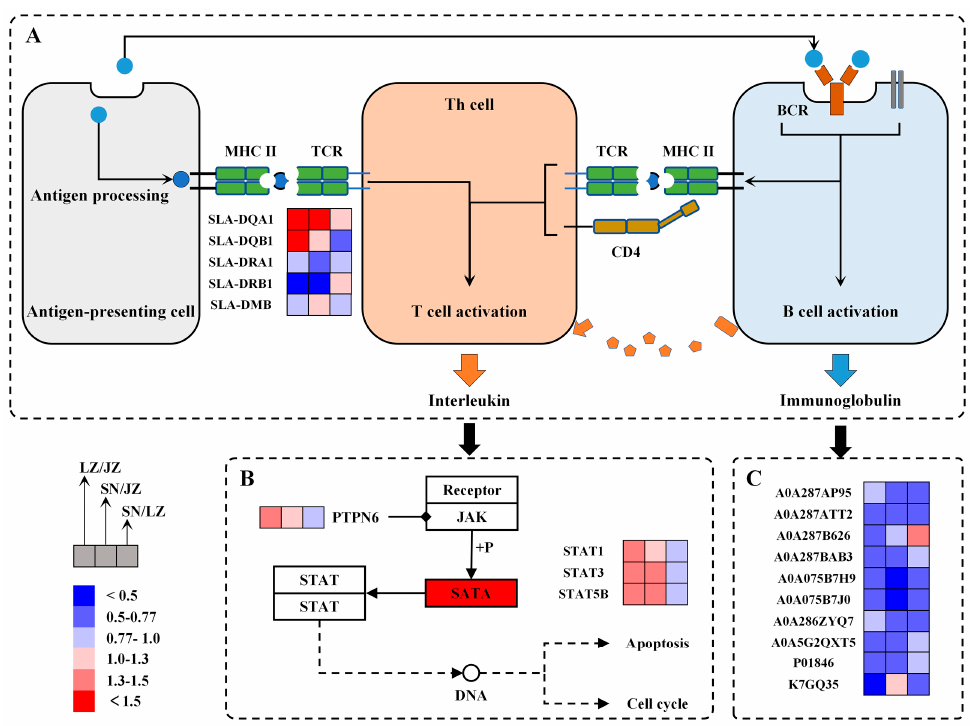
Figure 7. DEPs in immune-regulation-related pathways. ( A ) Antigen recognition and MHC II expression; ( B ) JAK-STAT signaling pathway; ( C ) immunoglobulin expression profile.